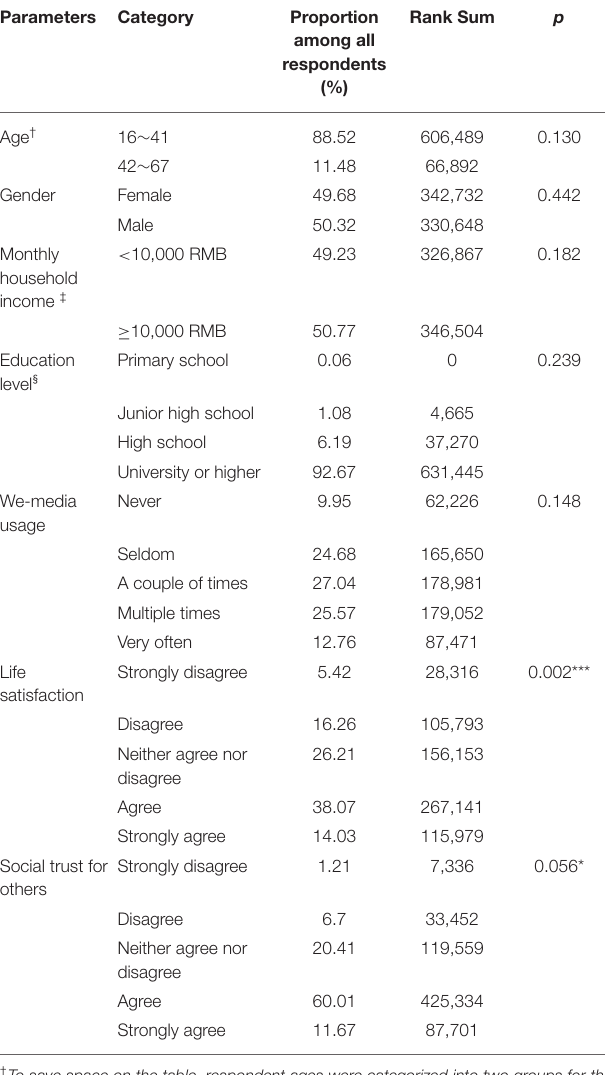
TABLE 3 | Association between trust in physicians and control